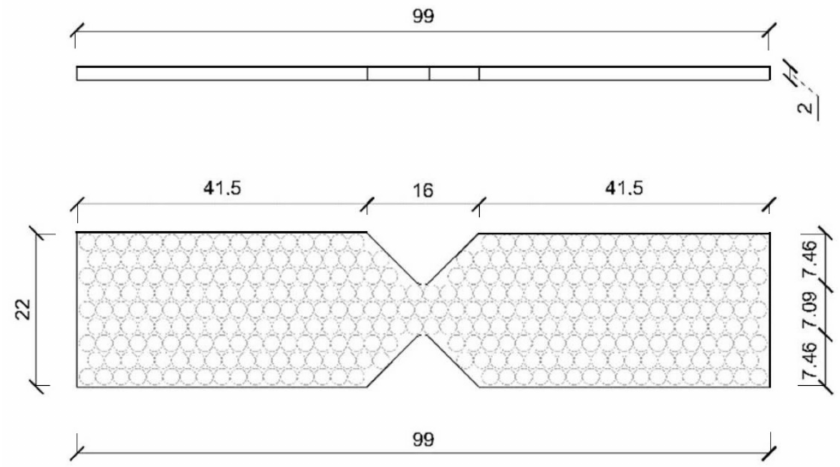
Figure 3. Schematic of the Iosipescu test and shear load applied in the sampled area. (red arrows show the shear load on the specimen and blue arrows the driving direction of the testing machine).